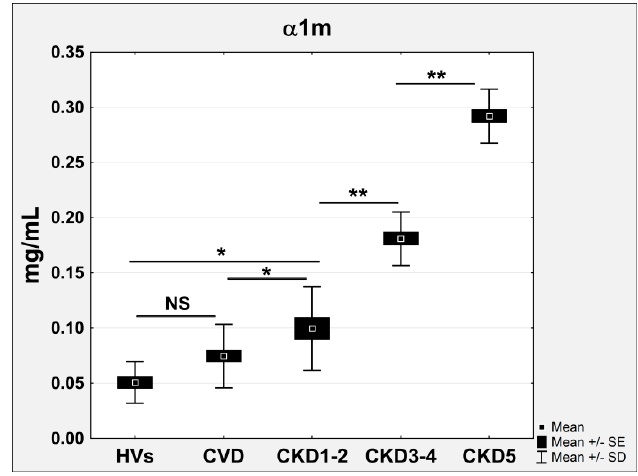
Figure 3. ELISA measurements of α 1m. Chart shows mean, standard error (SE), and standard deviation (SD) for all analyzed plasma samples. Student’s t -tests were completed and statistical significance is indicated (* p < 0.05, ** p < 0.001, NS: non-significant).